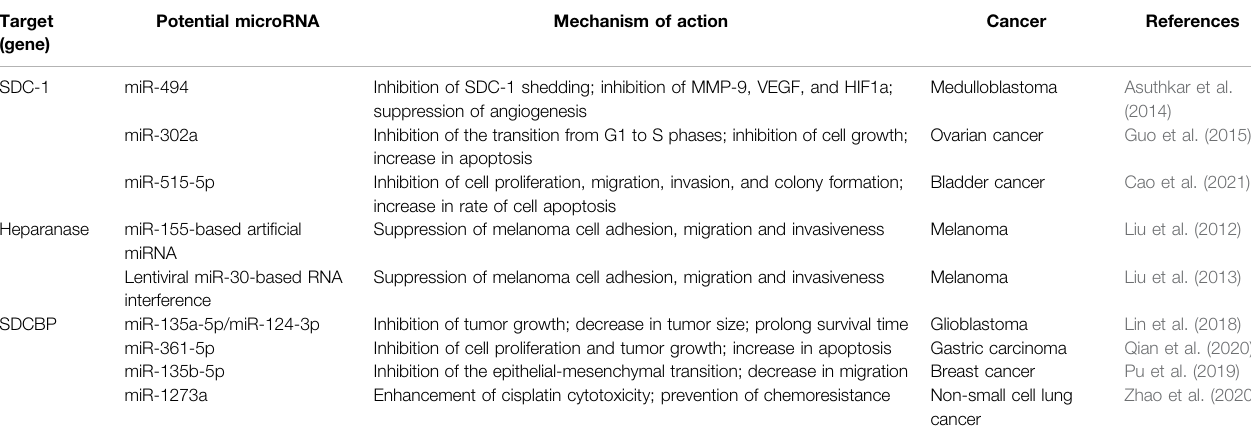
TABLE 2 | The targeting of SDC-1 and SDC-1-related proteins by microRNA. Target